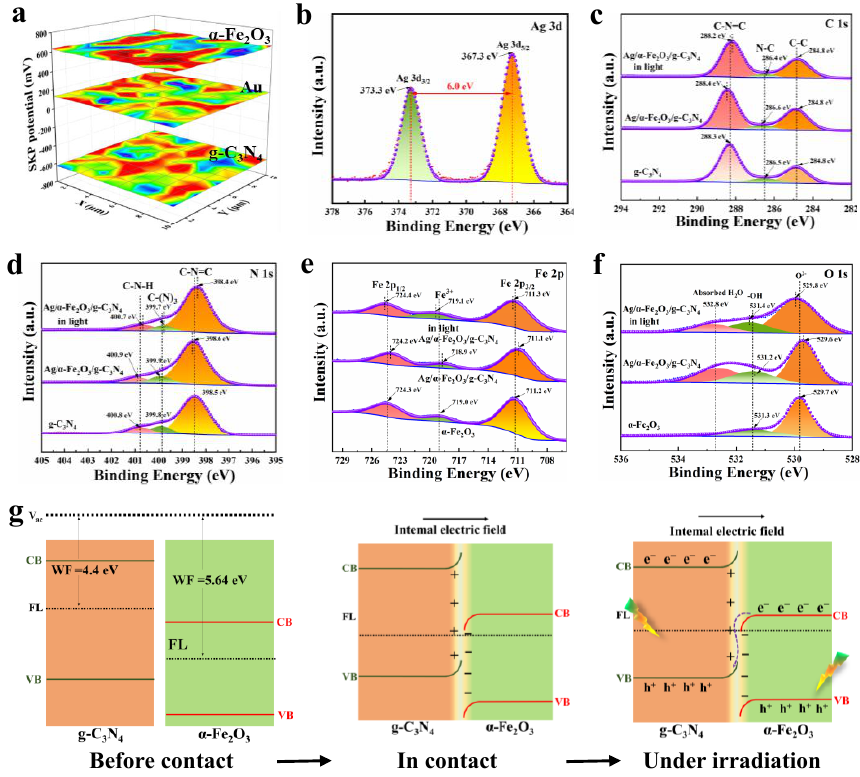
Figure 4. Work function of α -Fe 2 O 3 and g-C 3 N 4 ( a ). Ag 3d XPS spectra ( b ), the XPS spectra of C 1s ( c ) and N 1s ( d ) of g-C 3 N 4 and Ag/α -Fe 2 O 3 /g-C 3 N 4 , the XPS spectra of O 1s ( e ) and Fe 2p ( f ) of α -Fe 2 O 3 and Ag/α -Fe 2 O 3 /g-C 3 N 4 . ( g ) The formation mechanism of S-Scheme heterojunctions.